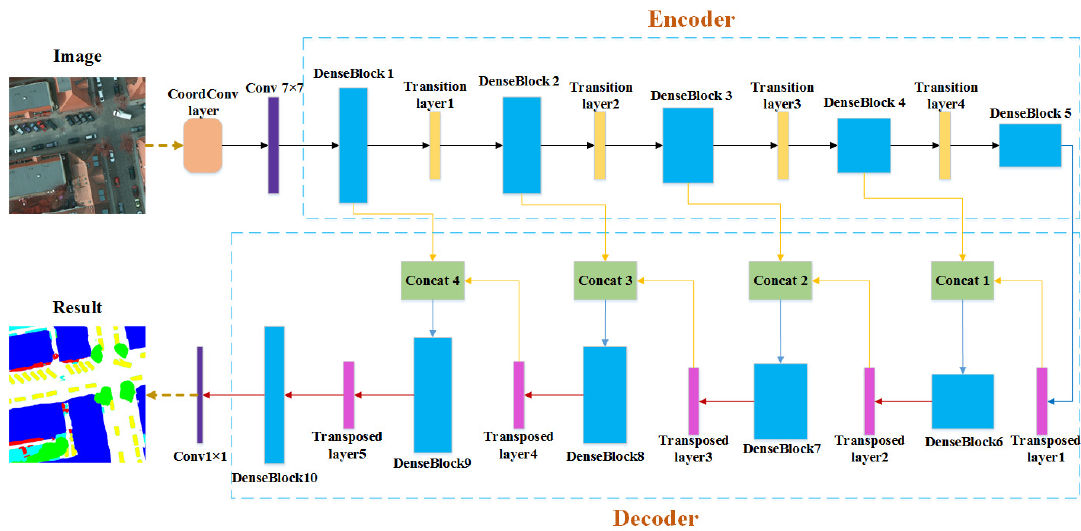
Figure 1. The overall architecture of the dense-coordconv network.